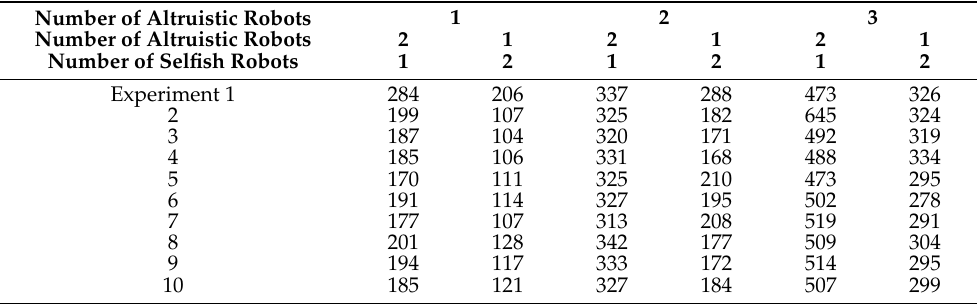
Table 2. Experimental records of the autonomous underwater robot task allocation. This table displays the time from the beginning to the completion of each experiment in seconds. The first row of the header gives the number of targets to be searched, and the second and third rows give the number of altruistic and selfish